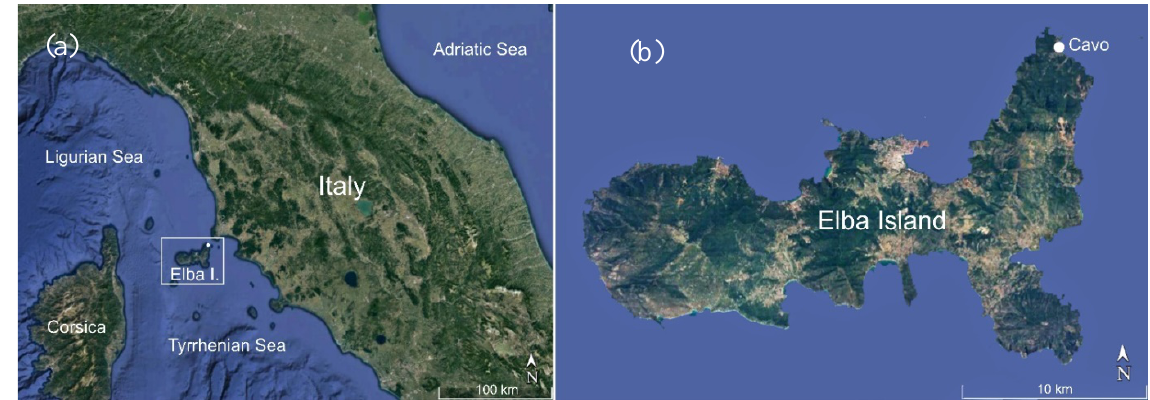
Figure 1. Location map of central-northern part of Italy ( a ) and Elba Island ( b ) (Google Earth).